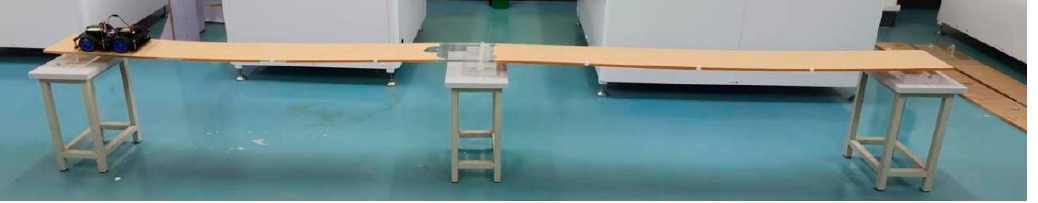
Figure 27. Dynamic load layout.